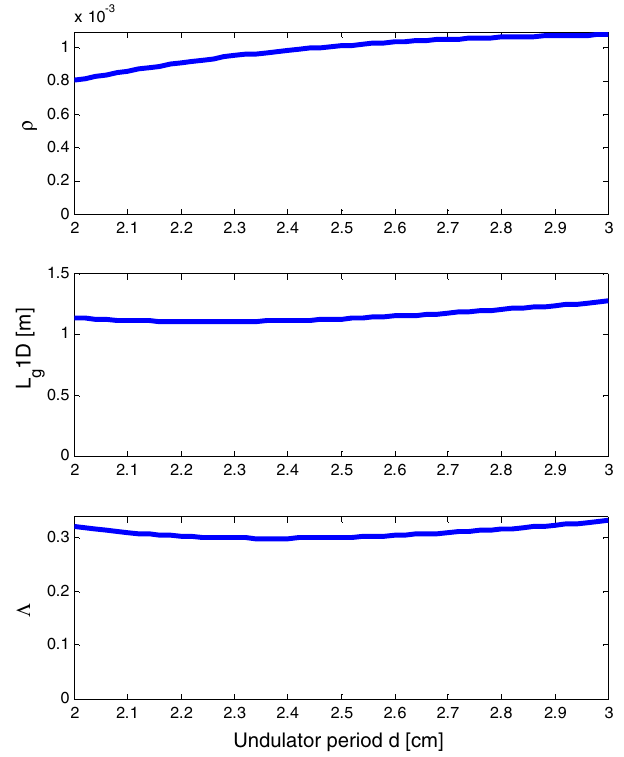
FIG. 4. The Pierce parameter (cid:6) , 1D gain length L (1D), g and 3D correction parameter (cid:3) as functions of the undulator ¼ 150 A , normalized emittance period d . Bunch current I b (cid:1)" rms ¼ 1 (cid:4) m , energy spread (cid:2) (cid:1) rms ¼ 0 : 02%